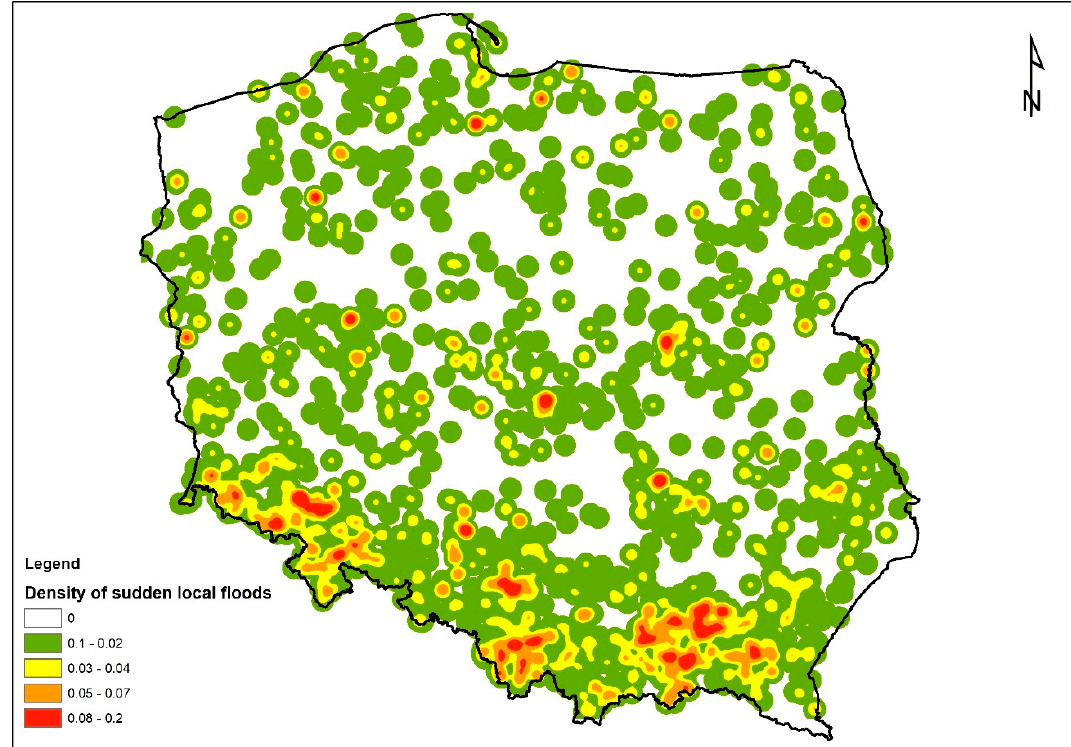
Figure 2. The spatial differentiation of the occurrence of rainfall floods as a result of high-efficiency precipitation. Source: Prepared on the basis of the results of the project [22].